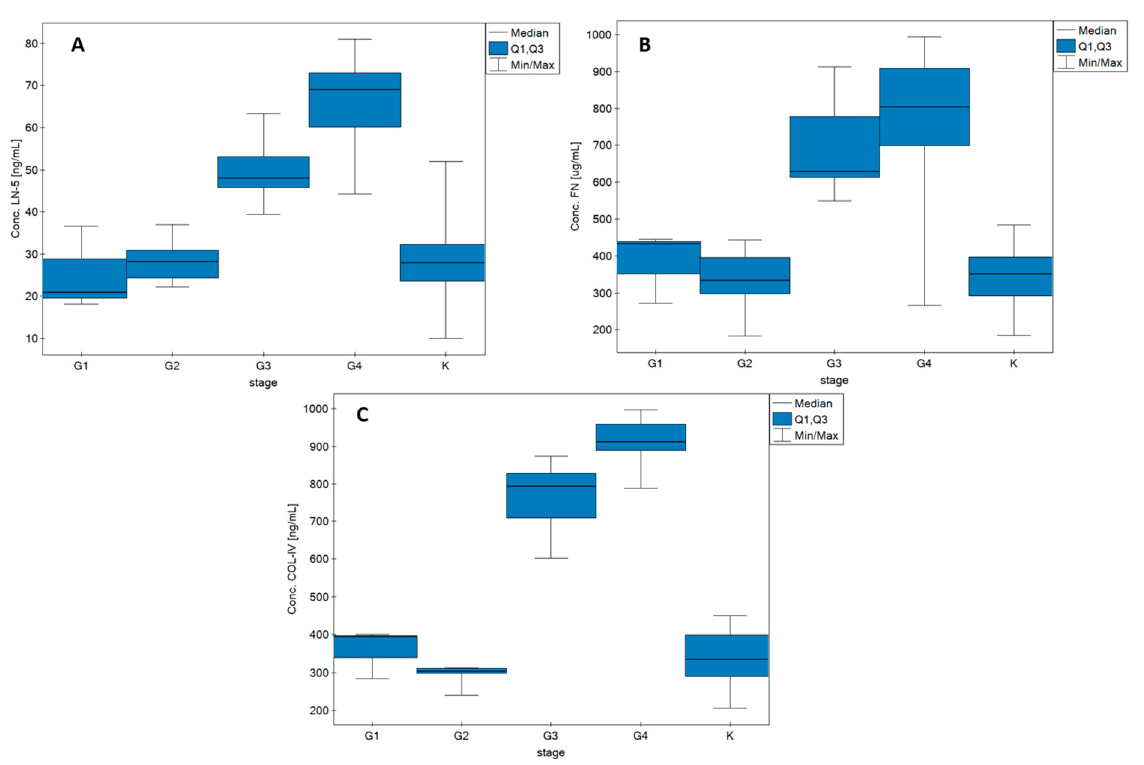
Figure 3. Box plots showing changes in concentrations of ( A ) LN-5, ( B ) FN, and ( C ) COL IV according to disease grade and in the control group.